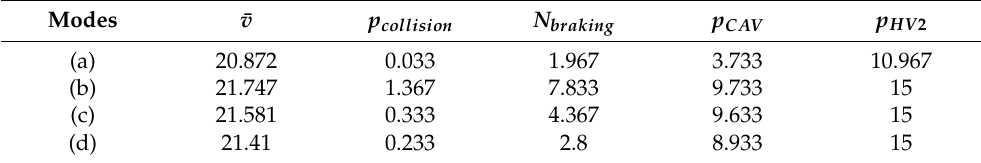
Table A2. Test evaluation